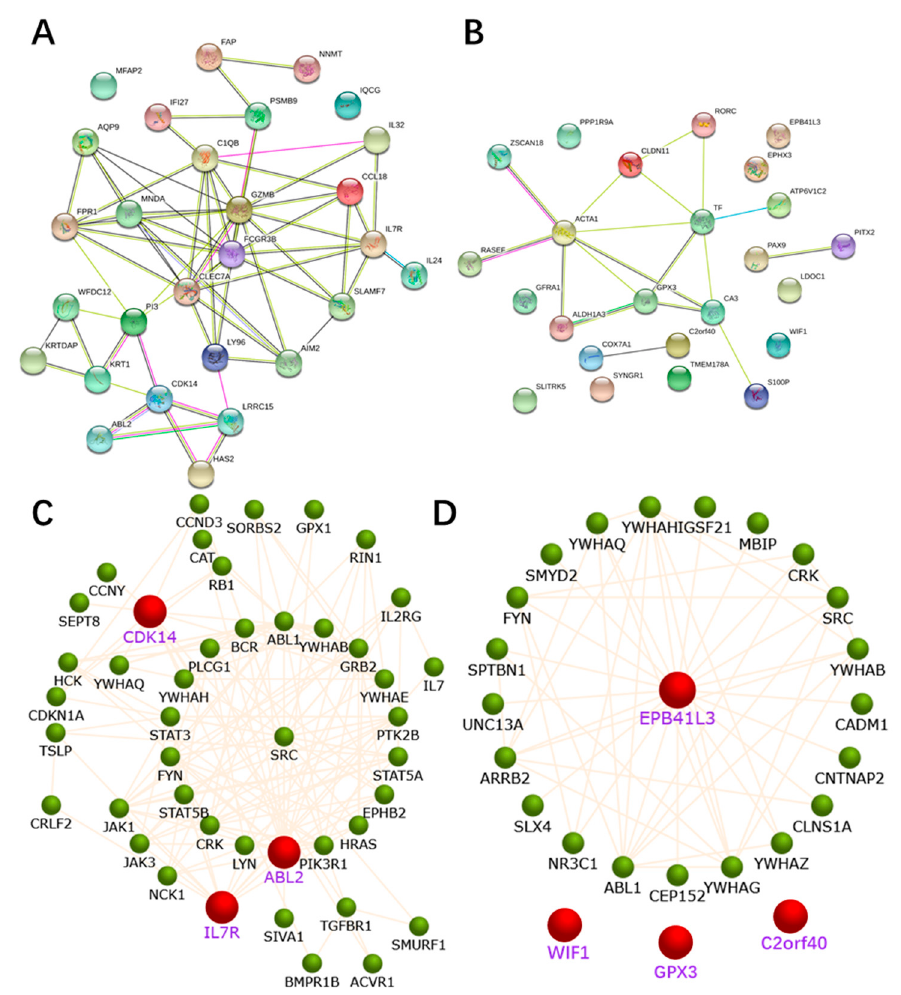
Figure 4. The protein–protein interaction (PPI) network complex for the aberrantly methylated differentially expressed genes. ( A ) A total of 28 genes were filtered into the upregulated hypomethylated PPI network complex using the STRING online database. ( B ) A total of 24 genes were filtered into the downregulated hypermethylated PPI network complex using the STRING online database. ( C ) The PPI network of the three up-hypomethylated oncogenes, and their related genes, created by the FunRich software. ( D ) The PPI network of the four down-hypermethylated TSGs, and their related genes, created by the FunRich software.